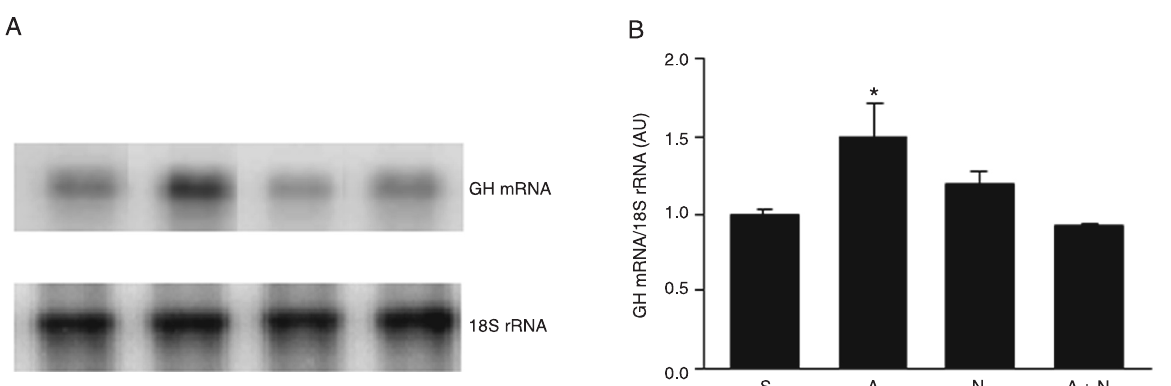
Figure 5. Effect of nifedipine plus arginine on GH gene expression. A , Typical autoradiograms of the GH mRNA and 18S abundance obtained in one experiment of a total of three. B , Quantitative representation of hybridization of GH and 18S rRNA transcripts ob- tained in all experiments. Hemi-pituitaries were incubated for 1 h with saline (S) or 71 mM arginine (A) in the presence or absence of 3 µM nifedipine (N and A+N). The values obtained from blot densitometry were normalized by 18S rRNA. Data are reported as means ± SEM in arbitrary units (AU). *P < 0.05 vs all other groups (one-way ANOVA followed by the Student-Newman-Keuls